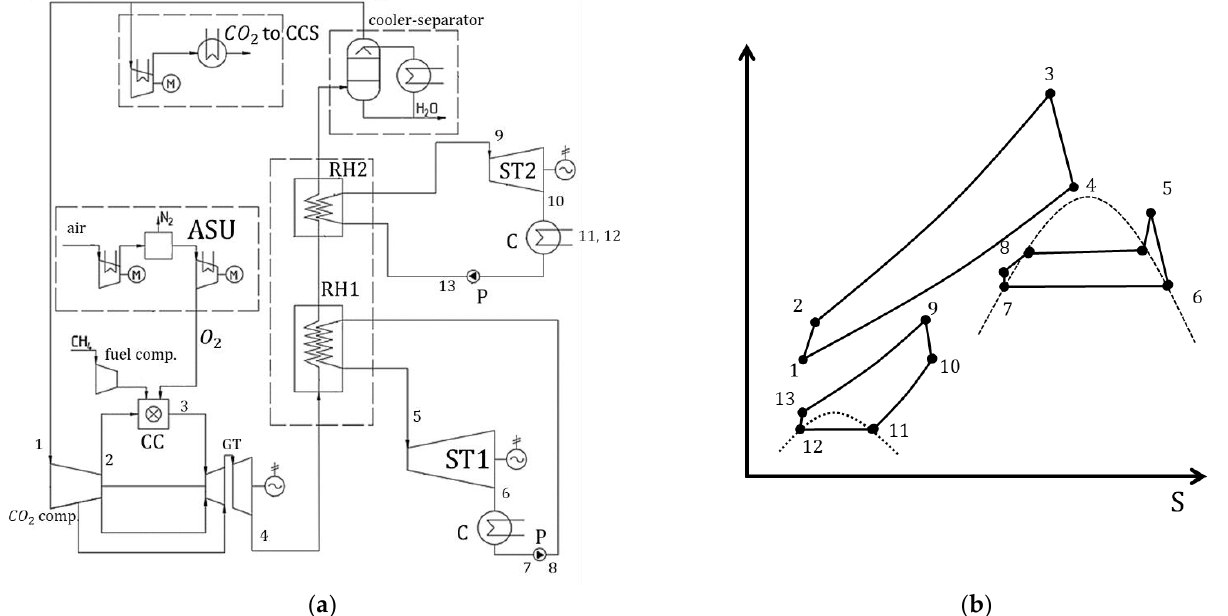
Figure 23. SCOC cycle with WHR: ( a ) schematic diagram; ( b ) T – S diagram [39]. ASU — air separation unit. Comp. — compressor; CC — combustion chamber; GT — gas turbine; ST — steam turbine; RH — regenerative heat exchanger; C — condenser; P — pump.